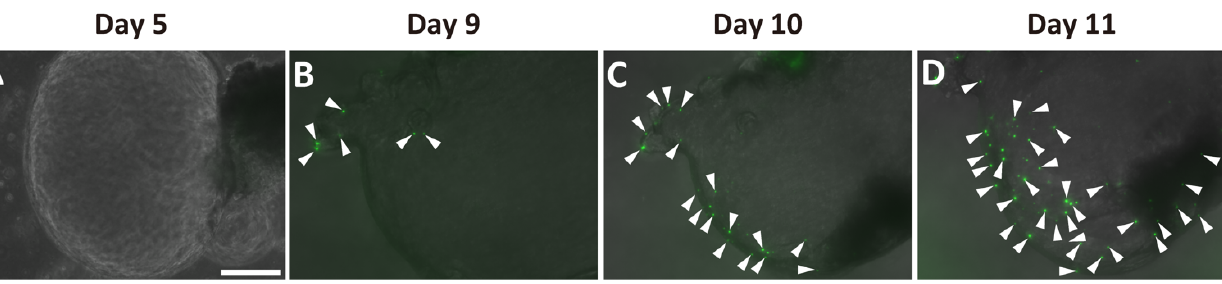
Figure 3. Emergence of Ngn3-GFP-positive cells in pancreatic ductal organoid. Ductal organoids were generated from Ngn3-GFP mice, and GFP expression, representing Ngn3 expression, was monitored. Ngn3-GFP expression was not ob- served on day 5 ( A ), but first appeared around days 7–9 of culture ( B ). GFP-positive cells started increasing thereafter ( B – D , arrowheads) (bar: 250 µm).